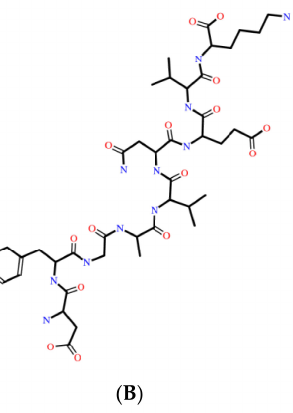
Figure 2. The 3D ( A ) and 2D ( B ) structures of bromelain-derived peptide ASP-TYR-GLY-ALA-VAL- ASN-GLU-VAL-LYS